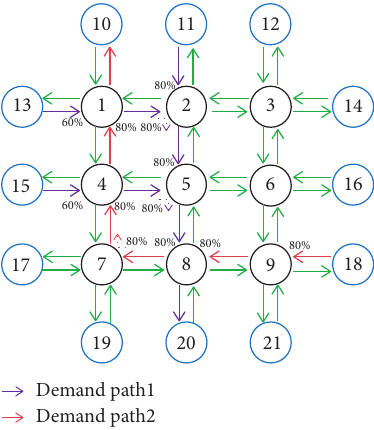
Figure 5: Small case study. The centroids are red, signalized in- tersections are red, and links are green.